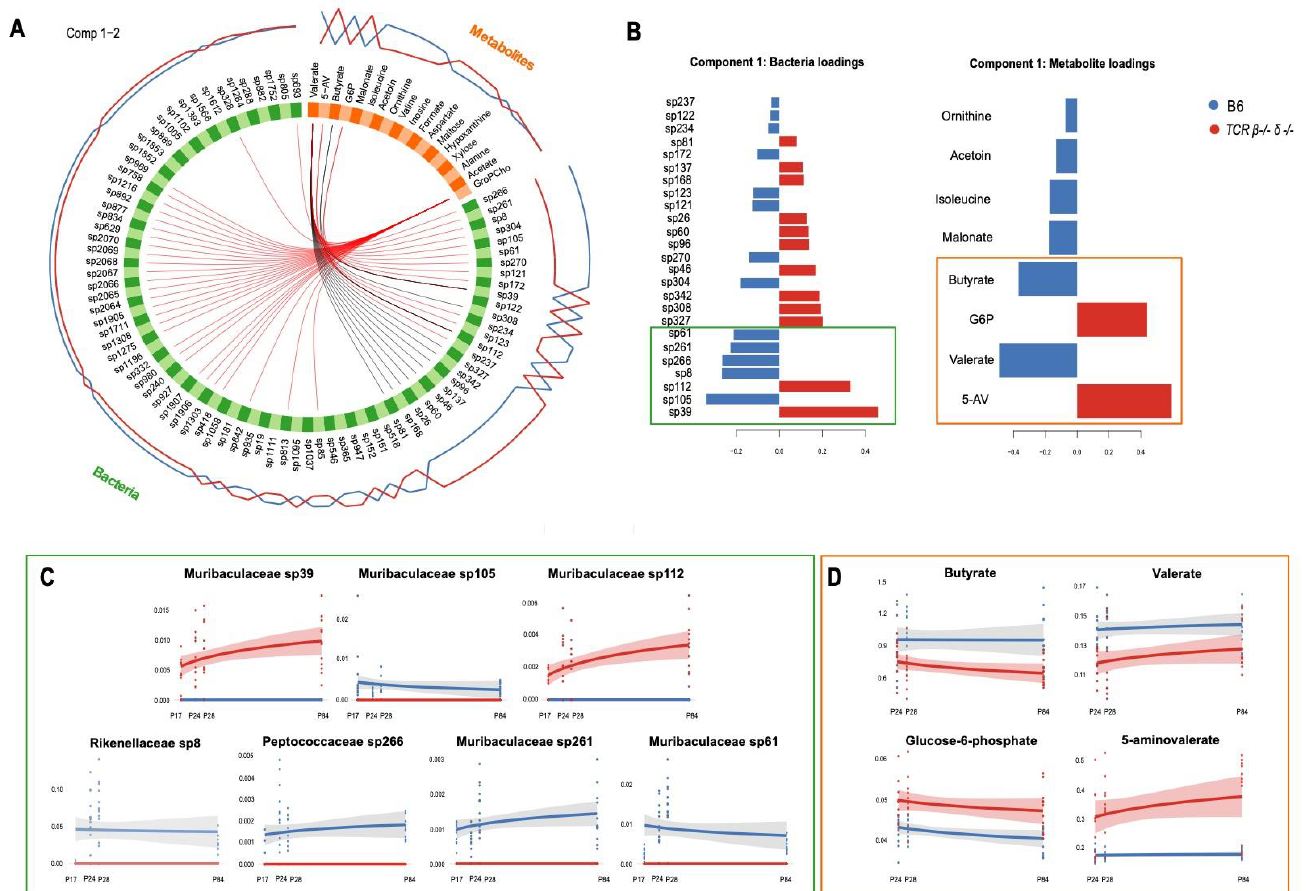
Figure 4. Integration of metabolic and bacterial abundance data. ( A ) Circos plot of the multi-block relationships across two principal components associated with T-cell deficiency. The correlation between variables of different blocks ( metabolites in orange, bacteria in green) are shown with red (if positive association) or black (if negative association) inner lines. The expression level of each variable is also shown as the blue (expression level in B6) and red (expression level in T cell receptor double knock out ( TCR β– / –δ– / – ) mice) lines on the outside of the circle. Only absolute correlations higher than 0.6 are shown. ( B ) Loading weights showing the best discriminating features on PC1 for both bacteria (left) and metabolites (right) blocks. The X-axis represents the coefficient weight of the variables listed on the Y-axis. In blue are the variables that have the maximum level of expression in B6, in red those maximally expressed in TCR β– / –δ– / – . ( C ) Trajectories of the top seven bacterial taxa (as per loading weights in panel B) across developmental timepoints in TCR β– / –δ– / – (red) and B6 mice (blue), supporting the correlations highlighted by the Circos plot. ( D ) Trajectories of the top four metabolites (as per loading weights in panel B across developmental timepoints in TCR β– / –δ– / – (red) and B6 mice (blue), supporting the correlations highlighted by the Circos plot. Shaded areas represent the confidence interval around smooth lines obtained by constructing a linear model with the formula y ~ log(x), where x = age and y = metabolite/bacterial abundance.